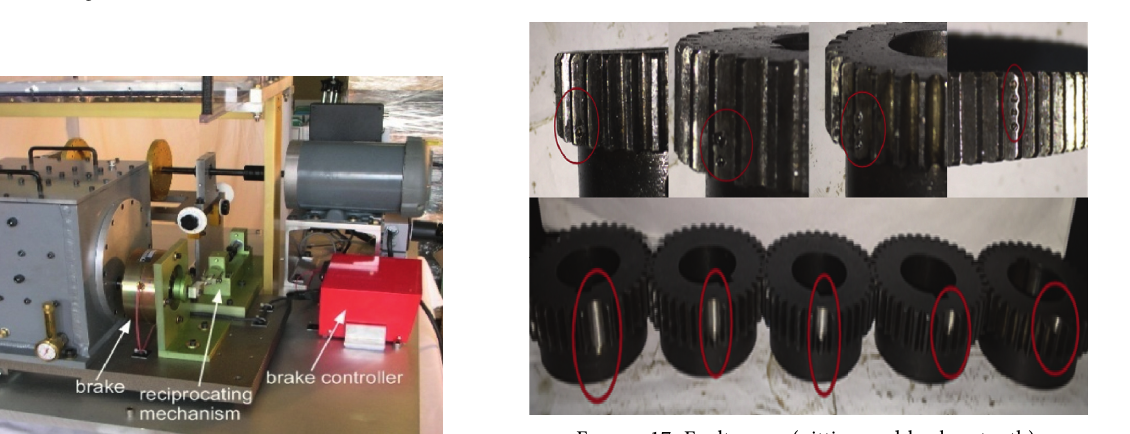
Figure 13: Recognition rate (44.67%) of test data.